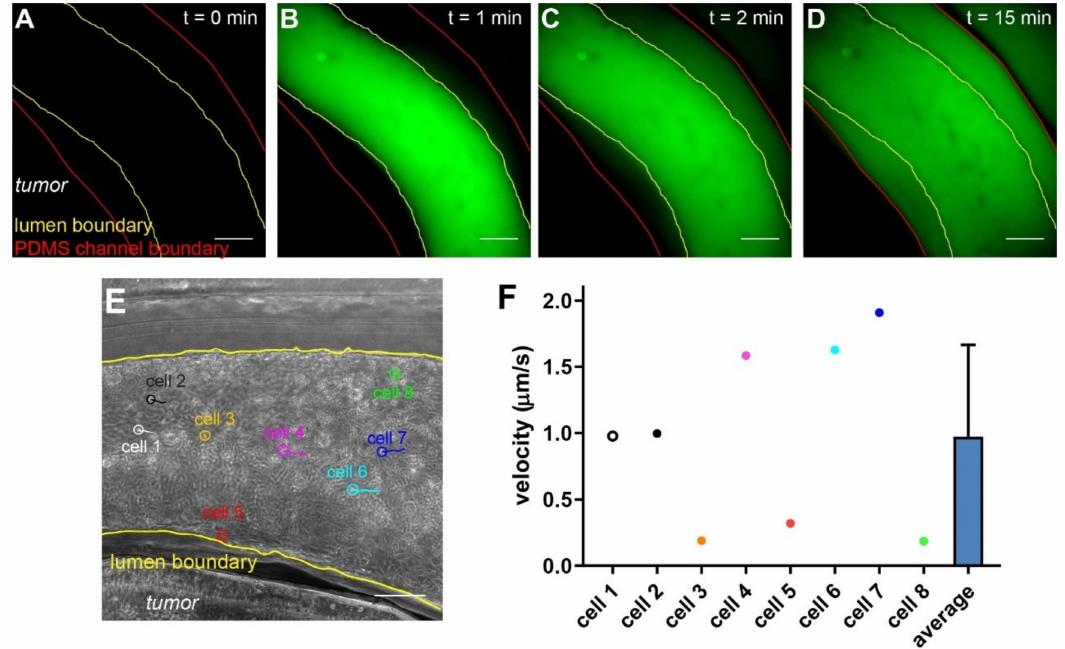
Figure 7. Assessing deliveries of molecules and cells in the vascularized tumor model. ( A – D ) Time series of the leakage of 70 kDa Dextran across the endothelium. ( E ) CAR T cells (circled) and their movement trajectories. ( F ) Velocity of CAR T cells in the vasculature ( n = 8). Scale bars: 250 µ